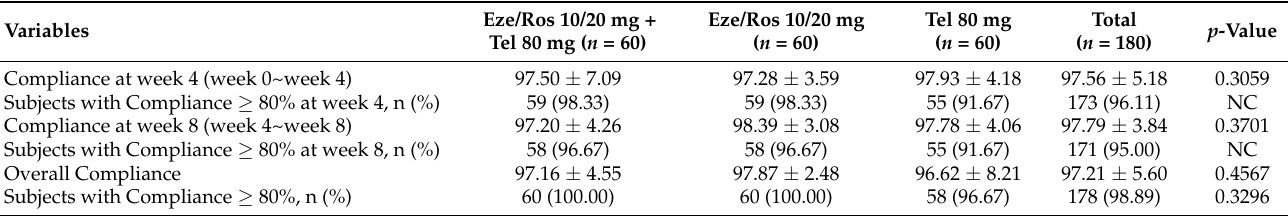
Table 4. Treatment